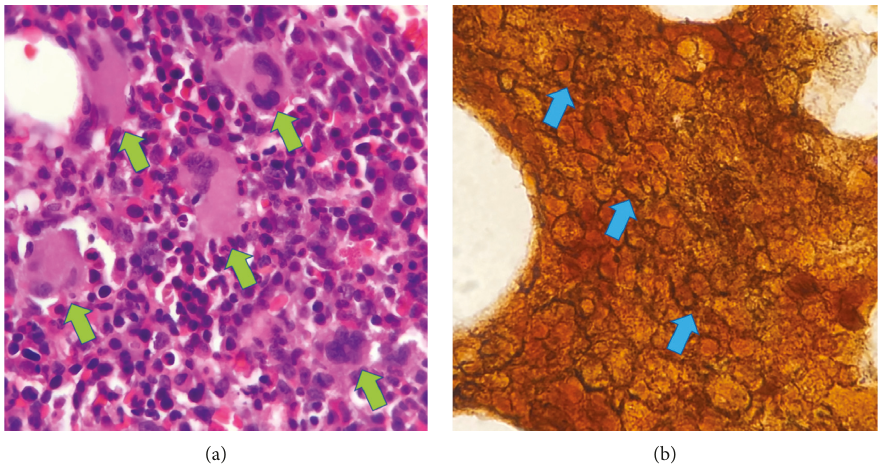
Figure 2: BM trephine biopsy. Normocellular marrow with megakaryocytic hyperplasia (small green arrows) in focal loose clusters (a). Reticulin staining showing moderate reticulin fibrosis (small blue arrows)